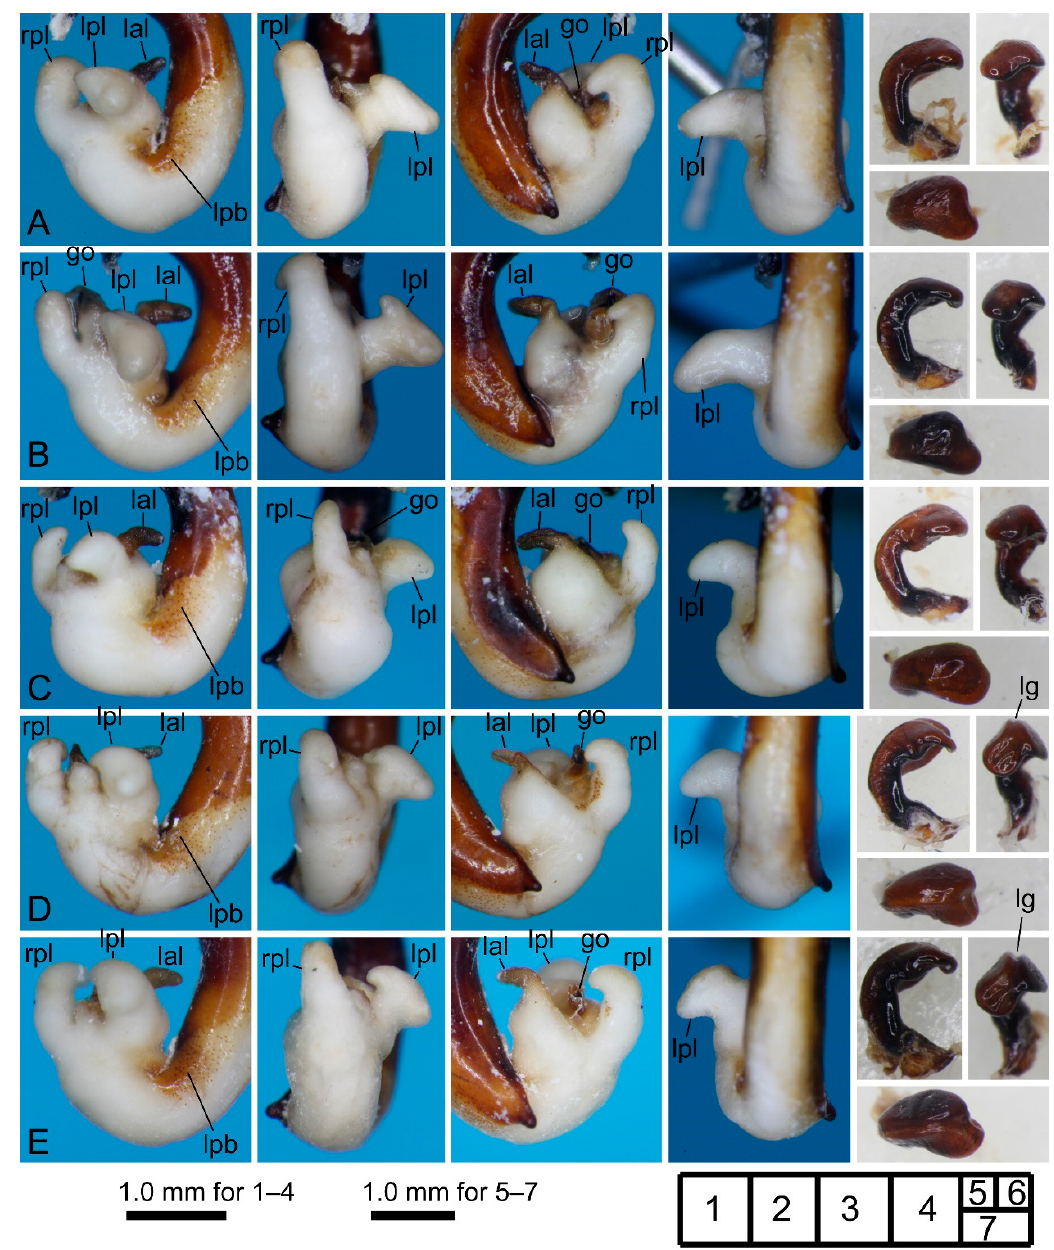
Figure 4. Left lateral ( 1 ), ventral ( 2 ), right lateral ( 3 ), and dorsal ( 4 ) views of aedeagus (part) with the everted endophallus and left lateral ( 5 ), apical ( 6 ), and dorsal ( 7 ) views of right paramere of Pterostichus falcispinus males from Kurosawagawa forest road ( A ), Togawa ( B ), Ôtori ( C ), Miyahisa ( D ), and Nukumidaira ( E ). lg: longitudinal groove.